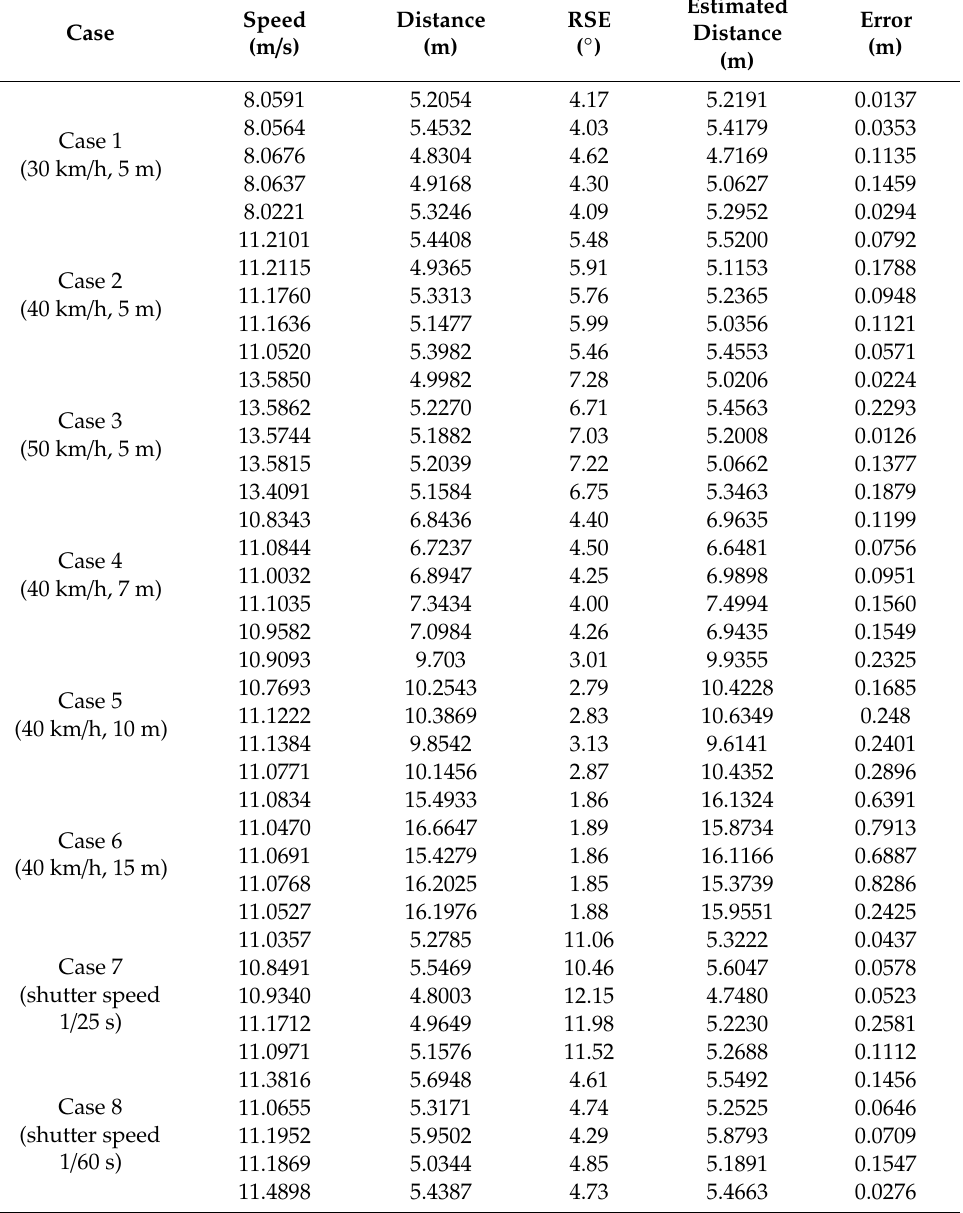
Table 2. RSE test